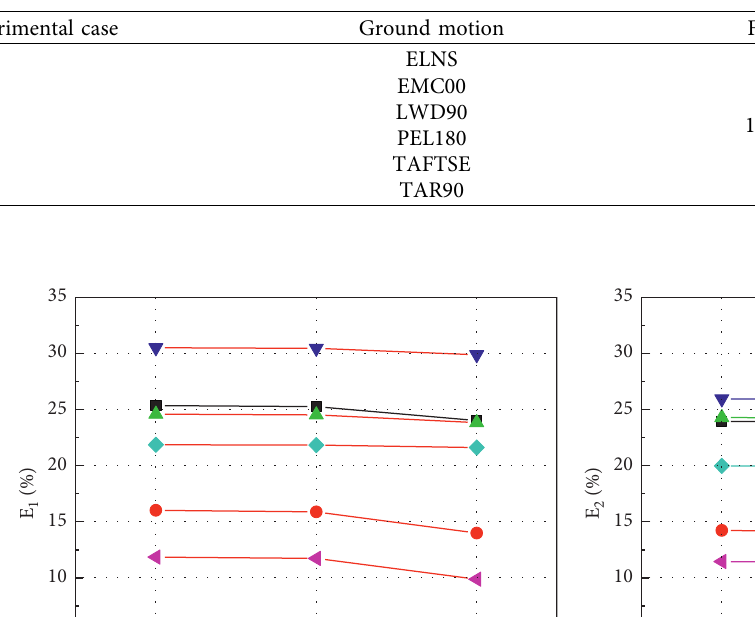
Table 8: Calculation schedule with PGA � 0.2g.